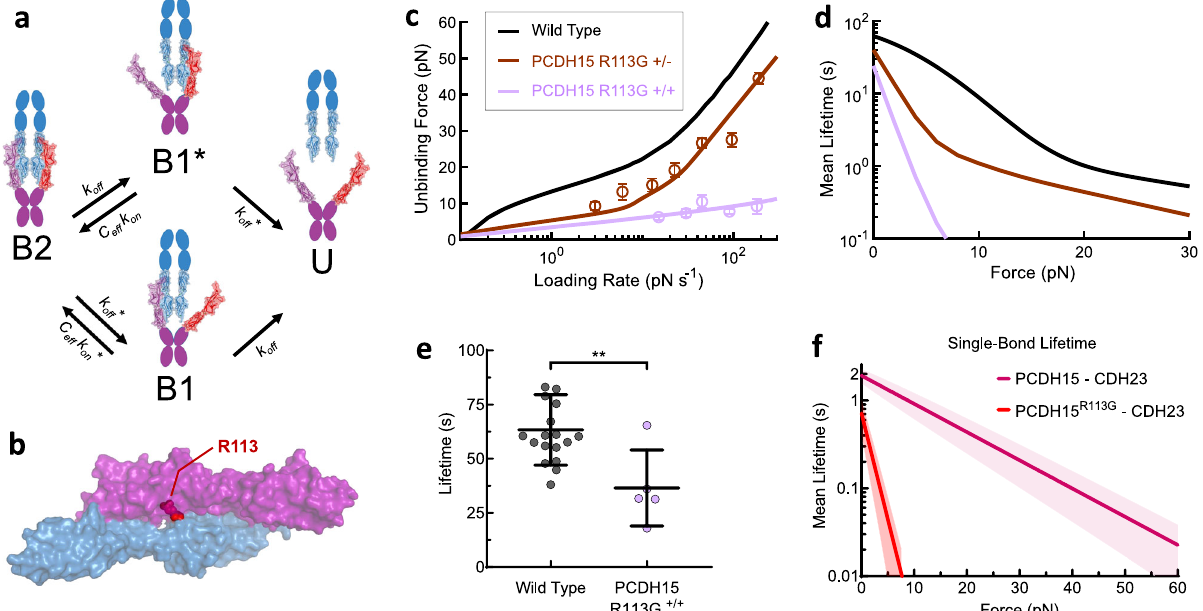
Fig. 5 The mechanical phenotype of a hereditary deafness mutation. a A kinetic state diagram representing a tip-link connection heterozygous for the R113G mutation (red) in PCDH15 (PCDH15 R113G + / − ). The doubly bound complex (B2) can transition to a single-bound state containing a mutated PCDH15 (B1*) or to a single-bound state with the wild-type PCDH15 (B1), with rates that differ between mutant and wild-type. b The location of the human deafness mutation R113G in the mouse PCDH15 – CDH23 bond interface (PDB 4AXW). c Unbinding forces from dimeric, full-ectodomain proteins measured at 2 mM Ca 2 + , with one (brown, n = 316 unbinding events) or both (purple, n = 264 unbinding events) PCDH15 strands mutated, simultaneously fi t with the three- and four-state models. Error is shown as the optimal bandwidth from a kernel density estimation. d Calculated mean lifetimes of the wild-type and mutant tip-link connections. e Scatter plot of zero-force tip-link lifetimes measured from biolayer interferometry experiments with PCDH15 R113G + / + proteins (mean ± SD). Wild-type lifetime = 64 ± 16 s ( n = 18 independent experiments), R113G + / + lifetime = 37 ± 18 s ( n = 5 independent experiments). The Student ’ s two-tailed unpaired t -test was used to determine statistical signi fi cance (** p = 0.0041). f Mean CDH23 – PCDH15 single-bond lifetime as a function of force, calculated from single-bond kinetics of the PCDH15 R113G – CDH23 bond with parameters extracted from simultaneous fi ts to PCDH15 R113G + / + and PCDH15 R113G + / − force spectroscopy data ( c ). Shaded bands are the propagated error of the fi t parameters f β and k off 0 . Relative to the wild-type tip-link bond, the R113G mutation increased both the zero-force single-bond off rate (from 0.5 to 1.4 s − 1 ) and the force sensitivity f β of the bond (from 13.5 to 1.8 pN). At a resting tension of 10 pN, a single wild-type bond lasts ~1 s, while a single PCDH15 R113G – CDH23 bond lasts <10